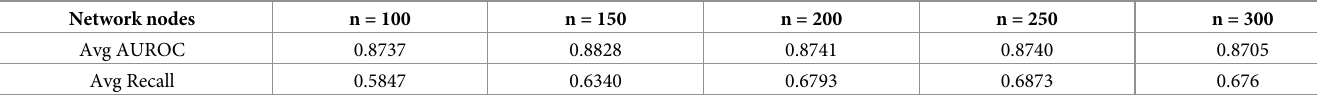
Table 3. Ranking performance based on different number of nodes added to disease subnetwork. Network